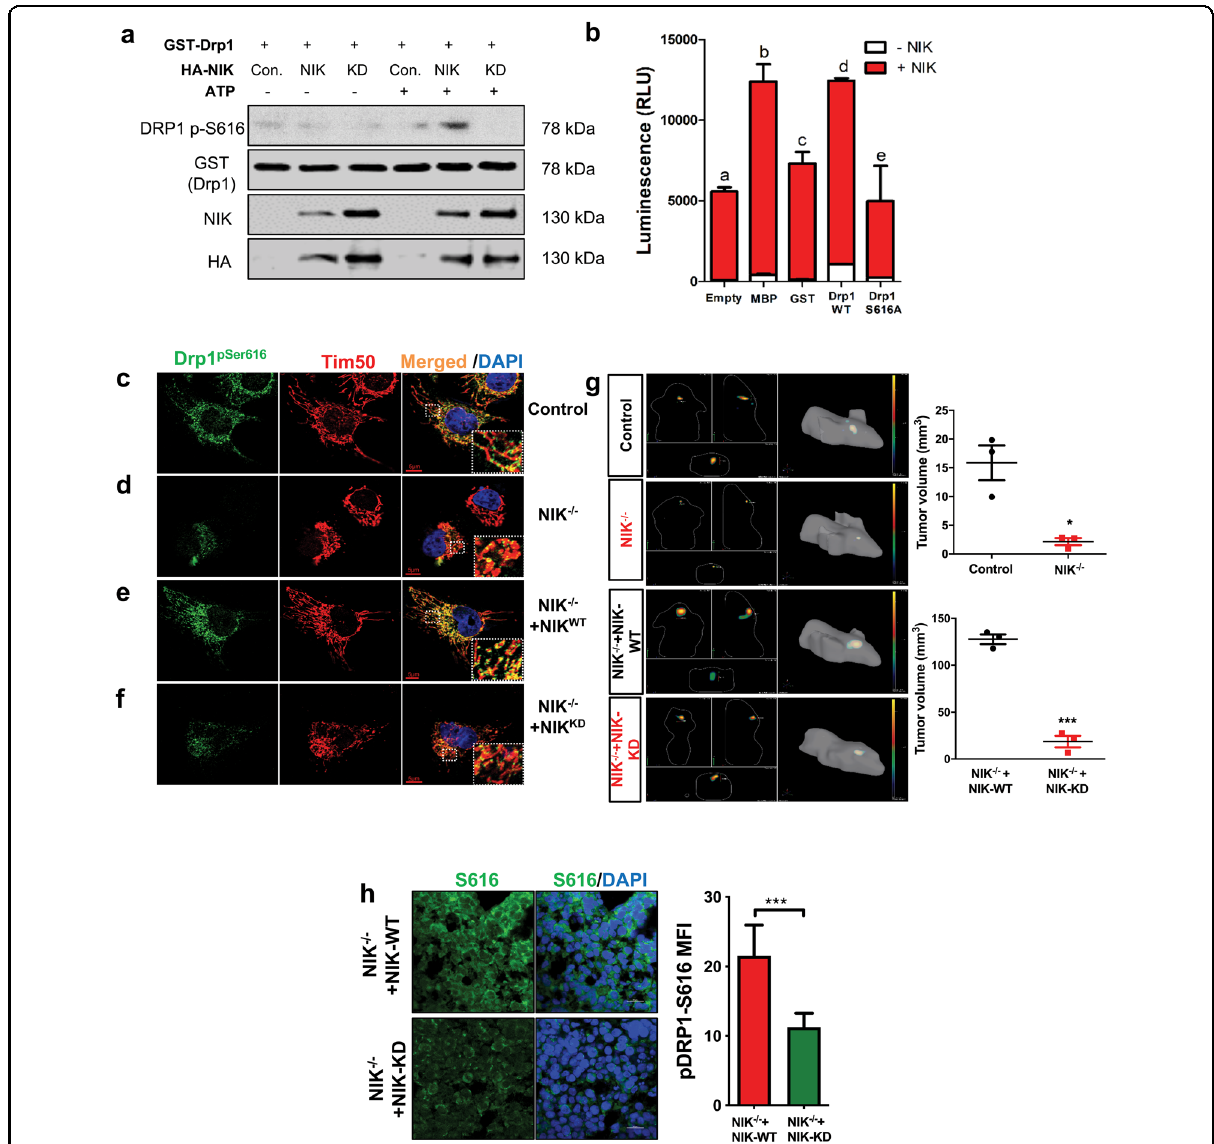
Fig. 6 NIK phosphorylates DRP1 at serine 616. a Kinase assays were performed using 293T cells transfected with HA-NIK wild-type (NIK) or kinase- dead mutant K429A/K430A (KD) expression vectors. NIK constructs were immunoprecipitated with anti-HA beads, and the immunocomplexes were incubated with puri fi ed GST-DRP1 518 – 736 in the absence or presence of 20 μ M ATP for 15 min at 37 °C. Kinase reactions were subjected to SDS-PAGE and probed with the indicated antibodies. b ADP-Glo kinase assay (Promega) was performed using 25 ng of puri fi ed recombinant human NIK protein (325aa-end) incubated with either GST alone, GST-DRP1 518 – 736 (DRP1 WT) or GST-DRP1 518 – 736,S616A (DRP1-S616A), or myelin binding protein (MBP, positive control). White overlay indicates level of NIK autophosphorylation. Different letters represent statistically signi fi cant differences (for “ a vs b ” and “ a vs d ” , p < 0.001; for “ b vs c ” , p < 0.01, for “ c vs d ” , p < 0.05; one-way ANOVA, n = 4). c – f BT25 control, BT25-NIK − / − , BT25-NIK − / − + NIK WT rescue, and BT25-NIK − / − + NIK KD rescue cells were immunostained using a DRP1-P616-speci fi c antibody (Green), Tim50 (red), and DAPI (blue). Scale bar, 5 μ m. Areas within dotted white squares are enlarged and shown on the right. g 3D rendering by In Vivo Imaging System (IVIS) of DiD labeled BT25 control, NIK − / − , NIK − / − + NIK-WT, and NIK − / − + NIK-KD cells at day 30. Tumor size (right graphs) was calculated at 30 days post injection of each cell type ( n = 3 per cell type). Tumor volume was calculated by the formula: tumor volume [mm3] = (length [mm]) × (width [mm]) × (height [mm]) × ( π /6) at 30 days post injection ( n = 3, respectively). Data represent average tumor volume ± S.E.M.; *** p < 0.001, unpaired Student ’ s t -test. Statistical signi fi cance was determined by Student ’ s t test, * indicates p < 0.05, *** indicates p < 0.001. h (Left) Immuno fl uorescence staining of NIK − / − + NIK-WT and NIK − / − + NIK-KD tumors with phospho-DRP1 S616 antibody, (right) fl uorescence intensity of phospho-DRP1 staining using n = 10 – 12 fi elds of view per cell type. Signi fi cance was determined by Student ’ s t test; *** indicates p < 0.001.